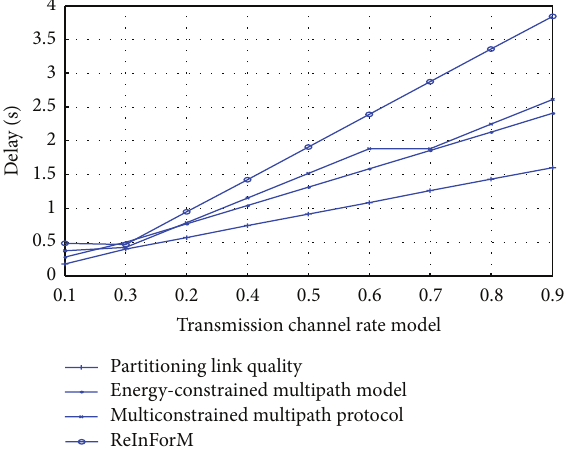
Figure 16: The average end-to-end delay comparison.